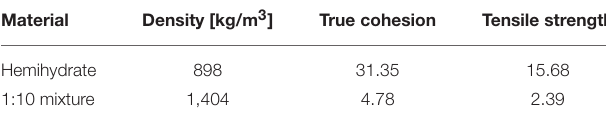
TABLE 1 | Mechanical properties of analog materials.